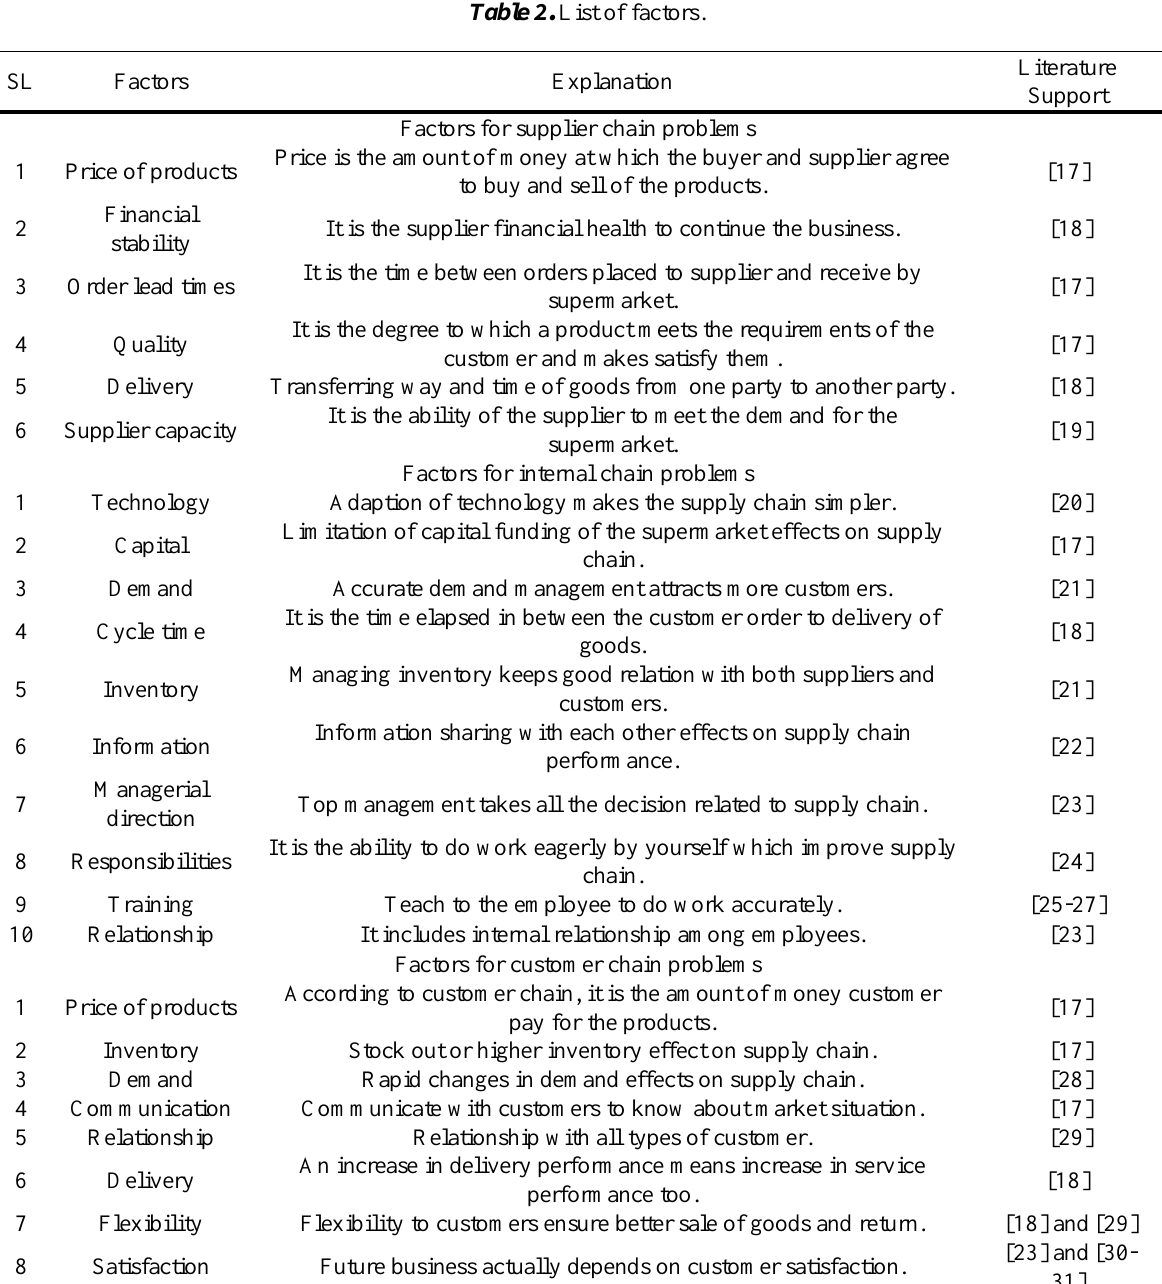
Table 2. List of